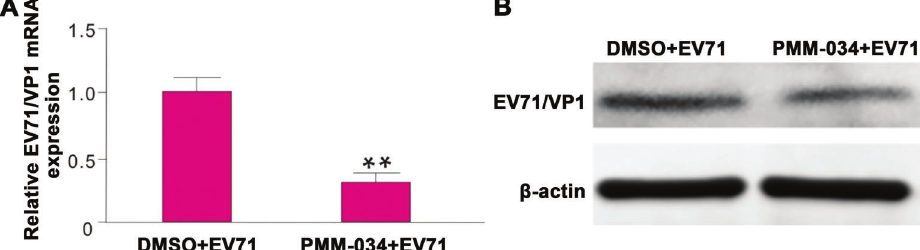
Figure 4. Effects of PMM-034 on human enterovirus 71 (EV71/VP1) mRNA and protein expressions in rhabdomyosarcoma (RD) cells. RD cells were infected with EV71 for 1 h and then treated with 10 m g/mL PMM-034 or DMSO for 23 h. A , The EV71/VP1 mRNA level was detected by real-time RT-PCR. GAPDH was used as the internal control. Data are reported as means ± SD of at least 3 independent experiments, **P o 0.01, Student ’ s t -test. B , Expression levels of EV71/VP1 protein were detected by western blotting. b -actin was used as the internal